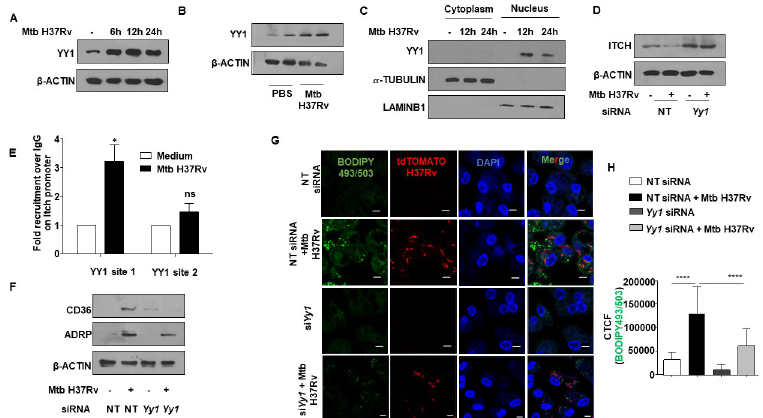
Fig 2. Transcription factor YY1 regulates ITCH repression during Mtb infection. (A) Mouse peritoneal macrophages were infected with Mtb H37Rv for the indicated time points and YY1 expression was analyzed in the whole cell lysates by immunoblotting. (B) BALB/c mice were aerosol-infected with Mtb H37Rv for 28 days. Protein levels of YY1 was analyzed in the lung homogenates of uninfected and infected mice by western blotting. (C) Mouse peritoneal macrophages were infected with Mtb H37Rv for the indicated time points. Cells were partitioned into nuclear and cytoplasmic fractions and assessed for the nuclear translocation of YY1 by immunoblotting. (D) Mouse peritoneal macrophages were transfected with NT or Yy1 siRNAs. Transfected cells were infected with Mtb H37Rv for 24 h and assessed for the expression of ITCH by immunoblotting. (E) Mouse peritoneal macrophages were infected with Mtb H37Rv for 24 h and assessed for the recruitment of YY1 over the Itch promoter by ChIP assay. (F) Mouse peritoneal macrophages were transfected with NT or Yy1 siRNAs. Transfected cells were infected with Mtb H37Rv for 24 h and assessed for the expression of ADRP and CD36 by immunoblotting. (G, H) Mouse peritoneal macrophages were transfected with NT or Yy1 siRNAs. Transfected cells were infected with tdTomato Mtb H37Rv for 48 h and analyzed for lipid accumulation (BODIPY493/503) by confocal microscopy; (G) representative image and (H) respective quantification. All immunoblotting, immunofluorescence and ChIP data are representative of three independent experiments. Lung homogenates from at least three mice were independently assessed for YY1 expression by immunoblotting. β -ACTIN, α -TUBULIN and LAMINB1 were utilized as loading control. NT, non-targeting; CTCF, corrected total cell fluorescence; ChIP, Chormatin immunoprecipitation; ns, non-significant. � , p < 0.05; ���� , p < 0.0001 (Student’s t-test in E, One way ANOVA in H; GraphPad Prism 6.0). Scale bar, 5 μ m.